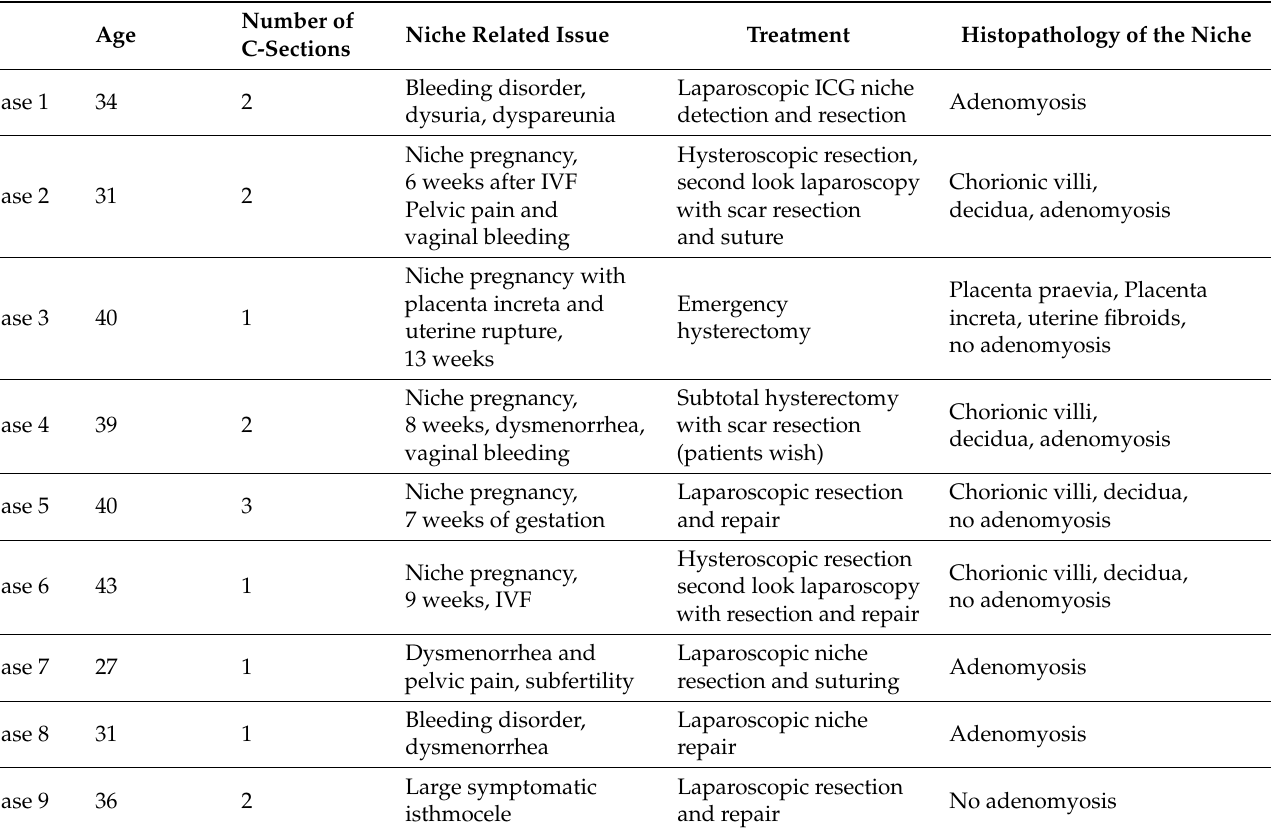
Table 1. Basic data of 9 patients with uterine niche related symptoms and